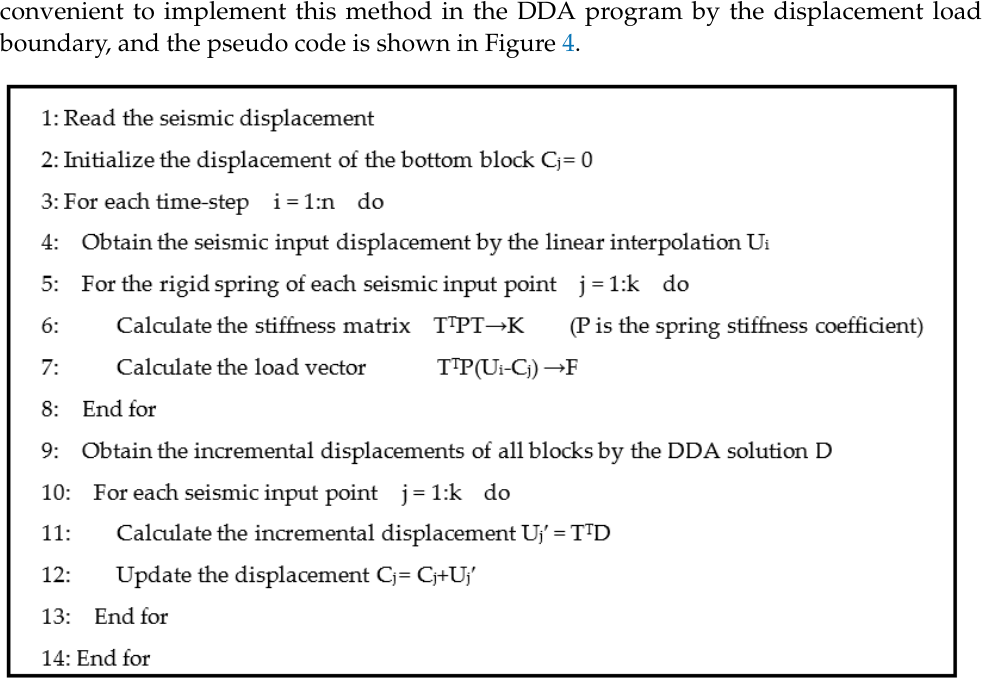
Figure 4. Pseudo code of the large stiffness method in the DDA program.